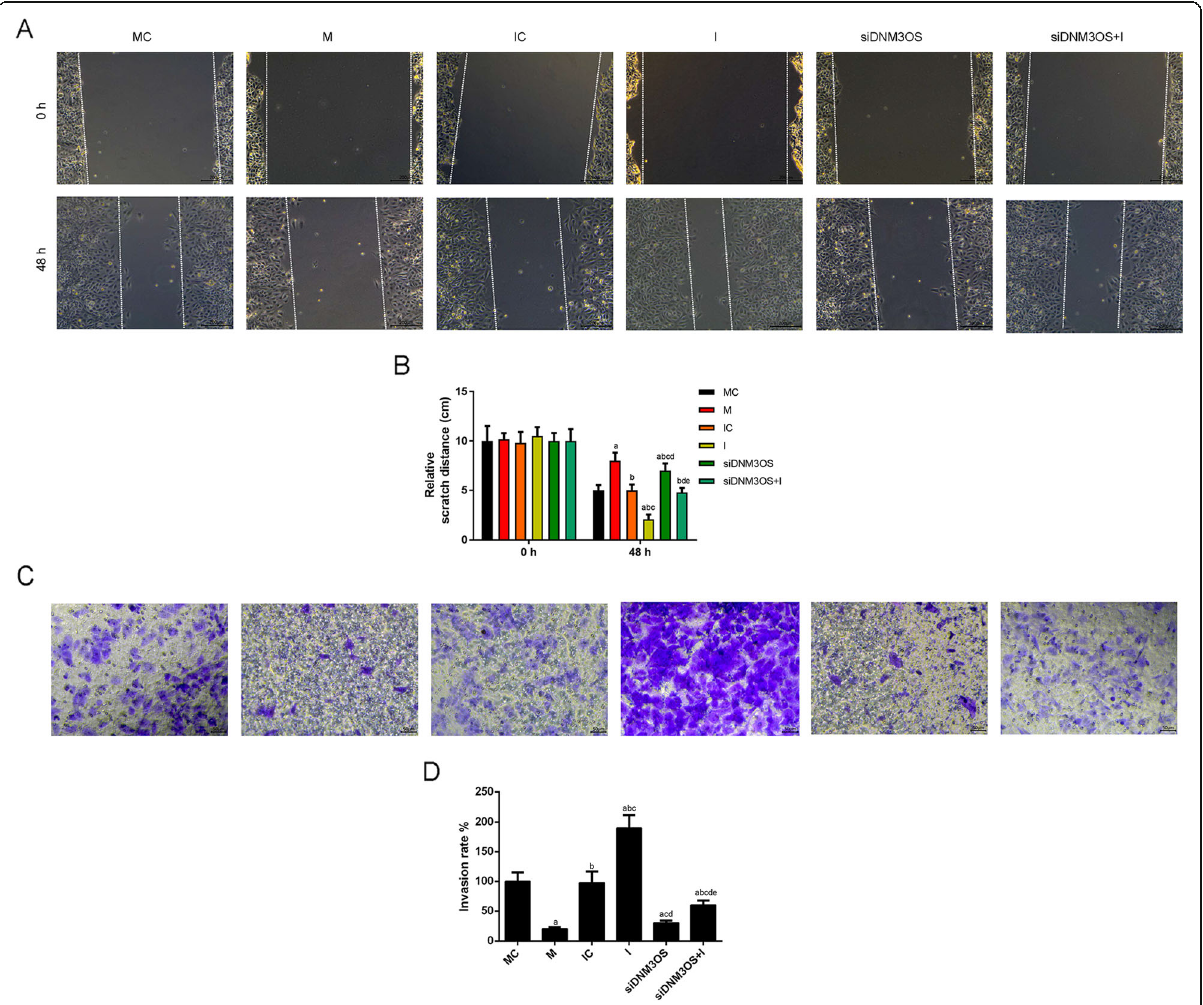
Fig. 6 DNM3OS down-regulation repressed migration and invasion by acting as a miR-126 sponge. ( a ) CHON-001 cells migration was inhibited by silencing DNM3OS, which reversed by miR-126 inhibitor using wound healing assay. ( b ) The distance of scratch was quantified. ( c ) CHON-001 cells invasion was inhibited by silencing DNM3OS, which was reversed by miR-126 inhibitor using transwell assay. ( d ) The number of invasion cells was quantified. a P < 0.05 vs. MC, b P < 0.05 vs. M, c P < 0.05 vs. IC, d P < 0.05 vs. I, e P < 0.05 vs. siDNM3OS. M: miR-126 mimic; I: miR-126 inhibitor; MC: miR-126 mimic control; IC: miR-126 inhibitor control; siDNM3OS: small interfering dynamin 3 opposite